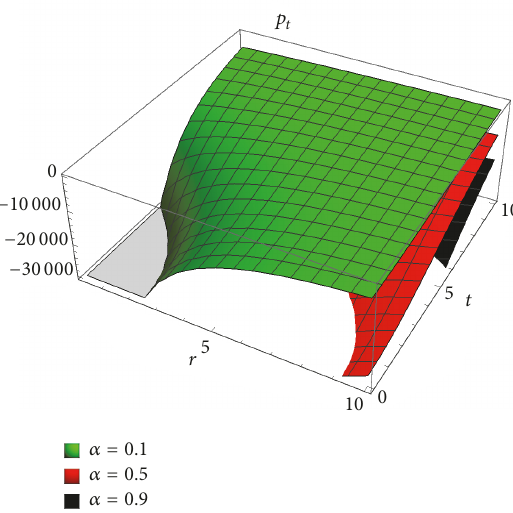
Figure 3: Tangential pressure along 𝑟 and 𝑡 for 𝑘 = 2.5 and the different values of 𝛼